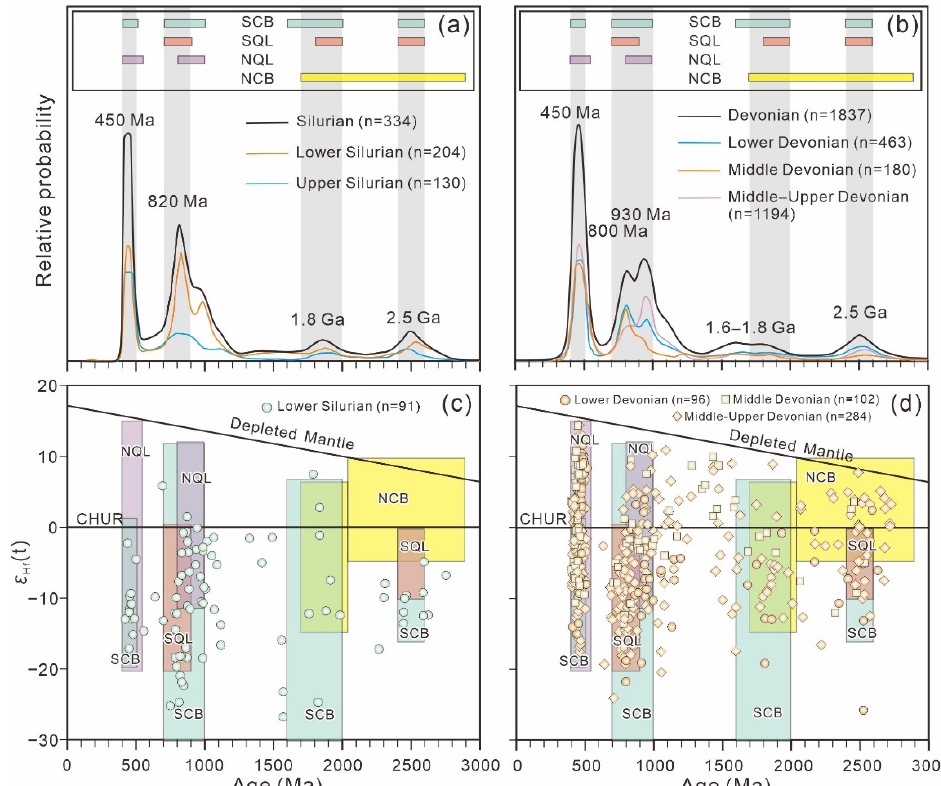
Figure 11. Detrital zircon U–Pb age spectra and ε Hf (t) values versus U–Pb age diagram from the Phanerozoic strata in the South Qinling Belt and the surrounding potential sources. ( a,c ) Silurian [52,62,63]; ( b,d ) Devonian (this study, [8,27,62,64–72]). Data for North China Block, South China Block, North Qinling Belt, and South Qinling Belt are from [27,52–55]. NCB = North China Block, NQB = North Qinling Belt, SQB = South Qinling Belt, SCB = South China